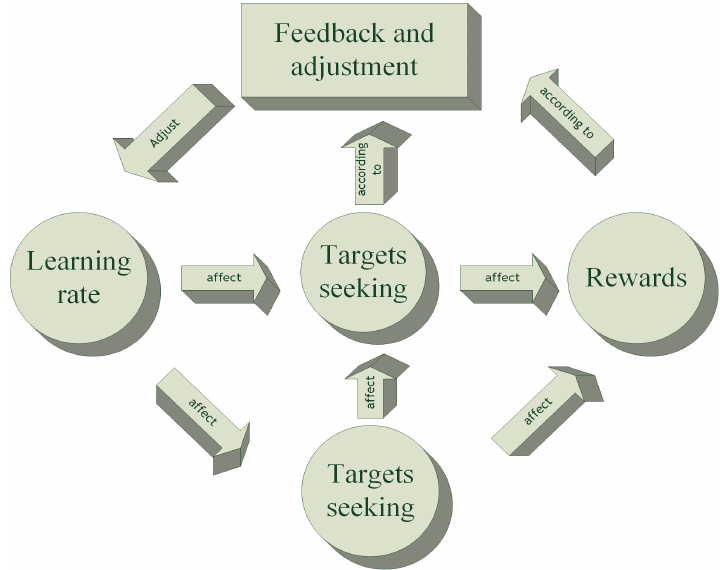
Figure 2. A new dynamic learning rate adjustment framework is more suitable for deep reinforcement